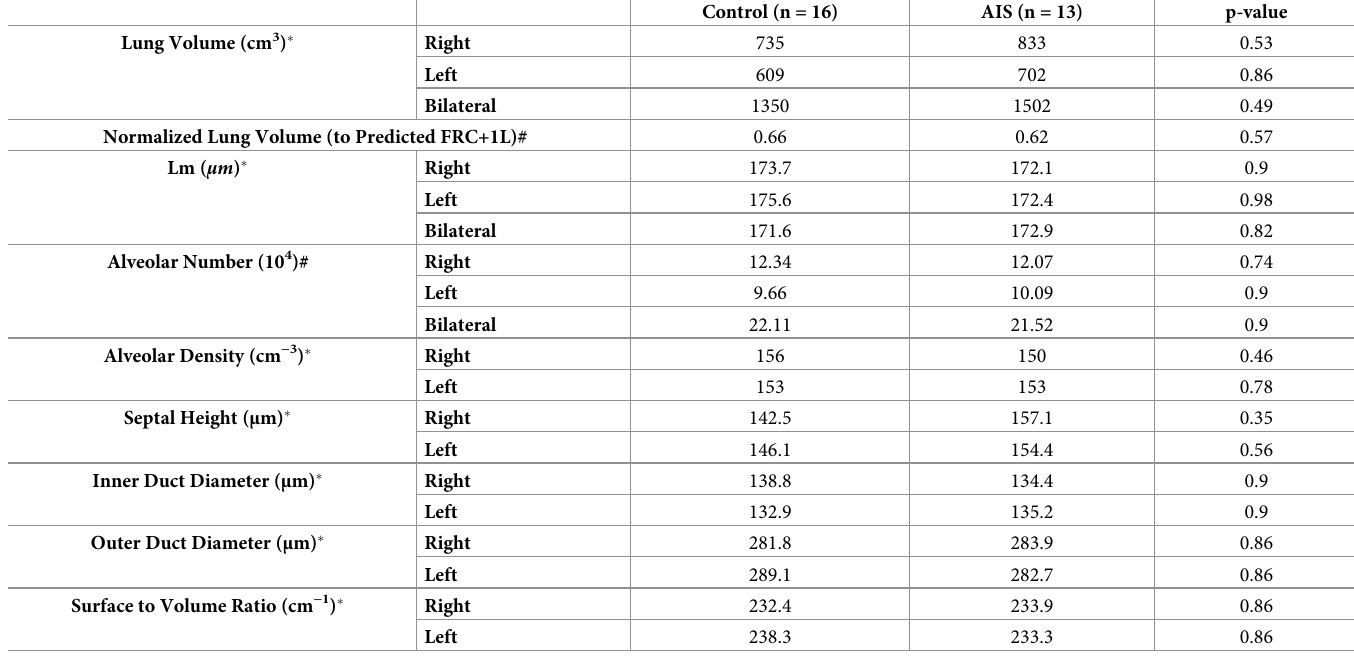
Table 2. Baseline differences between AIS and